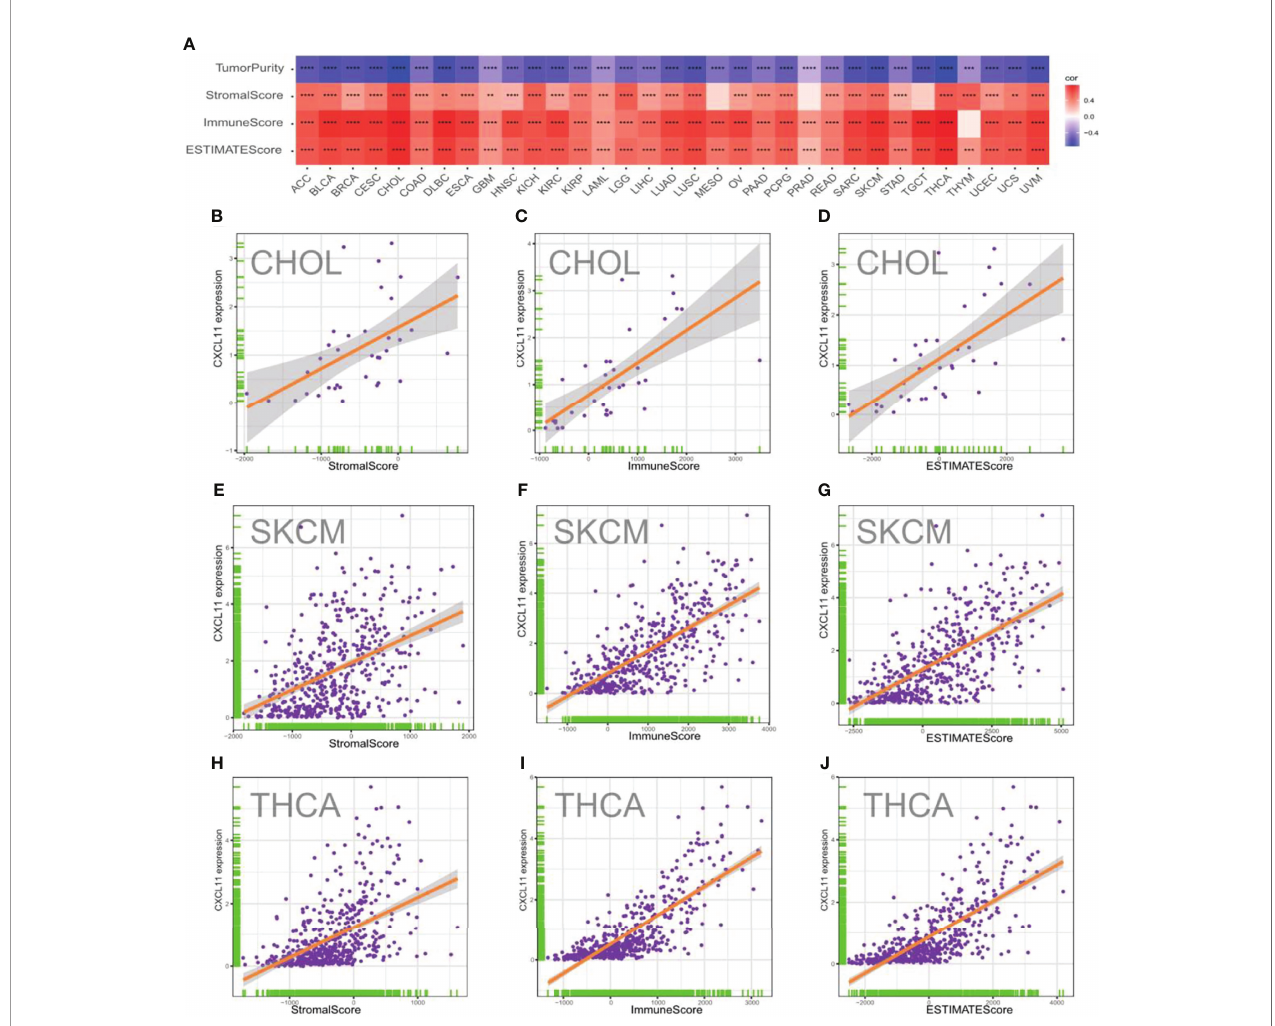
FIGURE 9 | Correlation between CXCL11 expression and ImmuneScore and StromalScore in pam-cancer. (A) Spearman ’ s correlation analysis of CD93 expression with ImmuneScore, StromalScore, and EstimateScore in pan-cancer (*p < 0.05, **p < 0.01, ***p < 0.001, ****p < 0.0001). Correlation between CXCL11 expression and three scores in CHOL (B – D) , SKCM (E – G) , and THCA (H – J)